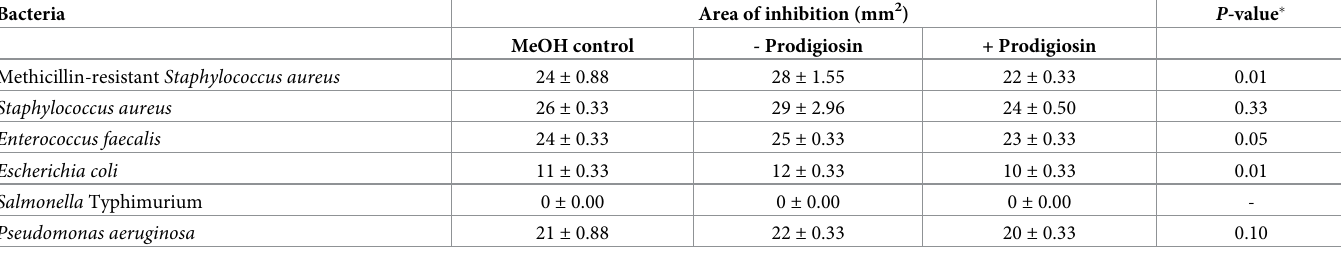
Table 3. Average area of proteolytic zones following prodigiosin treatment on the bacterial cultures for 24 hours. Data are presented as averages and standard devia- tions (n = 3). Bacteria Area of inhibition (mm 2 ) P -value � MeOH control - Prodigiosin +